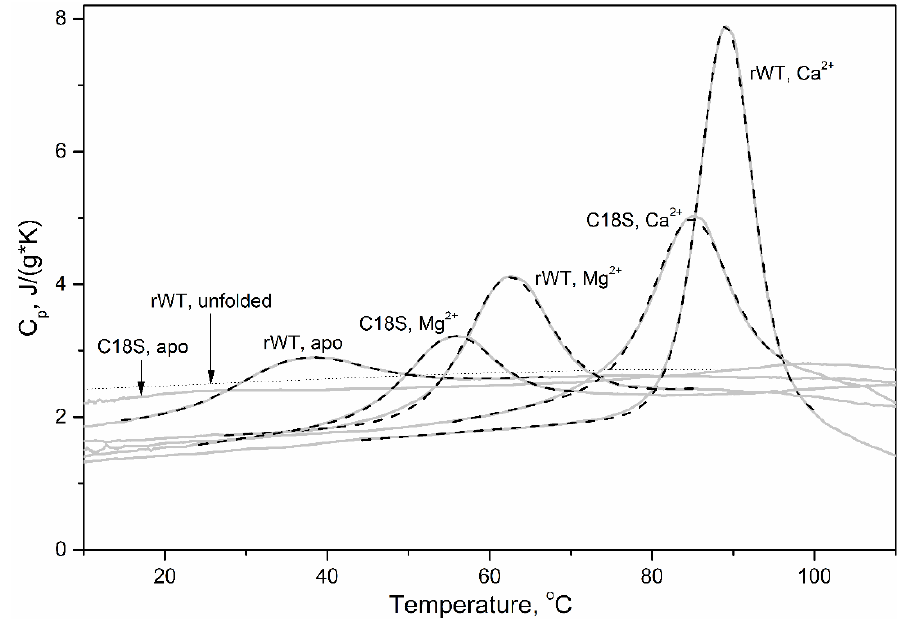
Figure 3. Temperature dependencies of specific heat capacities of apo- and metal-bound states of rWT/C18S Ocm, derived from DSC data [46]. Protein concentration was 1.2–2.1 mg/mL. Buffer conditions: 10 mM H 3 BO 3 -KOH, 1 mM CaCl 2 , pH 9.0 (Ca 2+ -bound Ocm), 20 mM glycine-KOH, pH 9.2, 1 mM EDTA (apo-Ocm), or 20 mM glycine-KOH, pH 9.2, 1 mM MgCl 2 (Mg 2+ -bound Ocm).